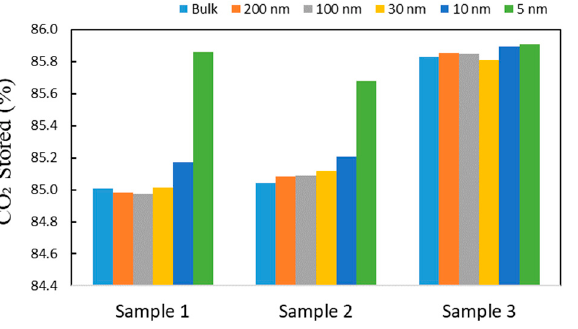
Figure 19. Percentage of CO 2 stored during CO 2 HnP scenarios for fluid samples at different pore confinement. pore